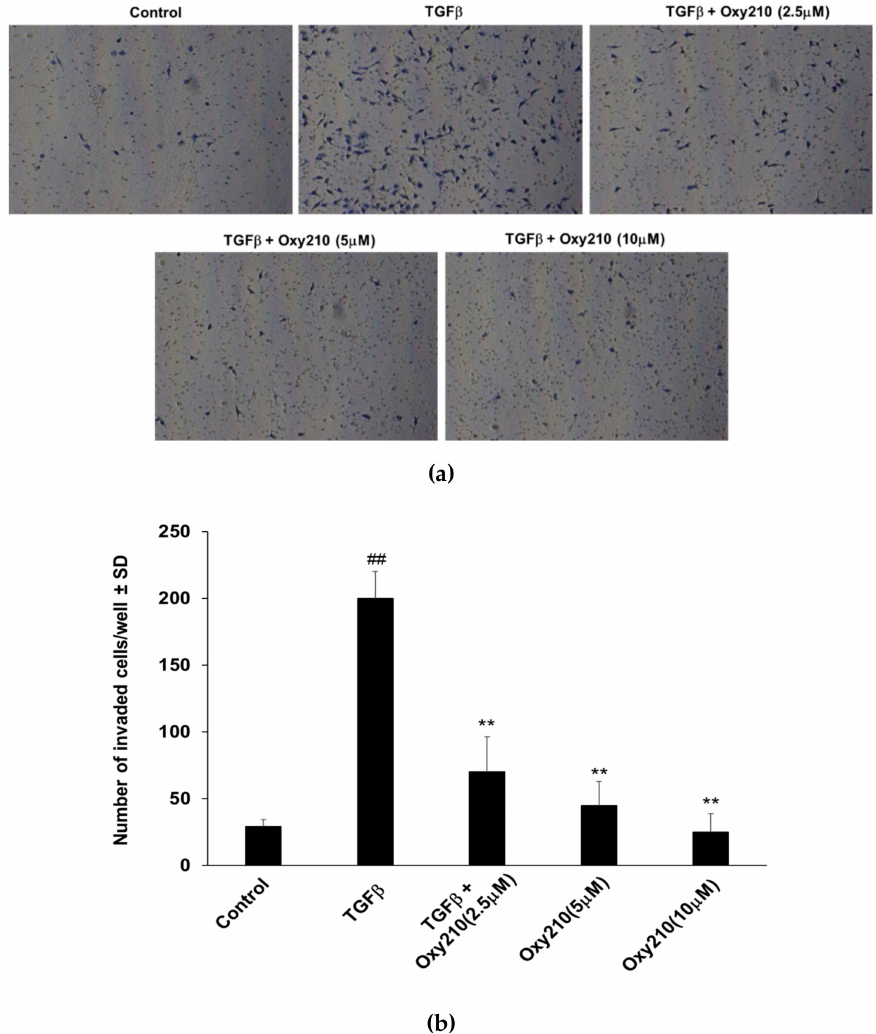
Figure 9. Inhibition of TGF β -induced invasive activity of A549 cells. In vitro invasion assays were performed using chambers with matrigel-coated membrane as described in the Materials and Methods section. ( a ) Images of invaded cells on the membranes. ( b ) Quantitative analysis of invasion of A549 cells induced by TGF β in the absence or presence of Oxy210. Data from a representative experiment are reported as the mean of triplicate determinations ± SD (** p < 0.01 vs. TGF β treated cells; ## p < 0.01 vs.